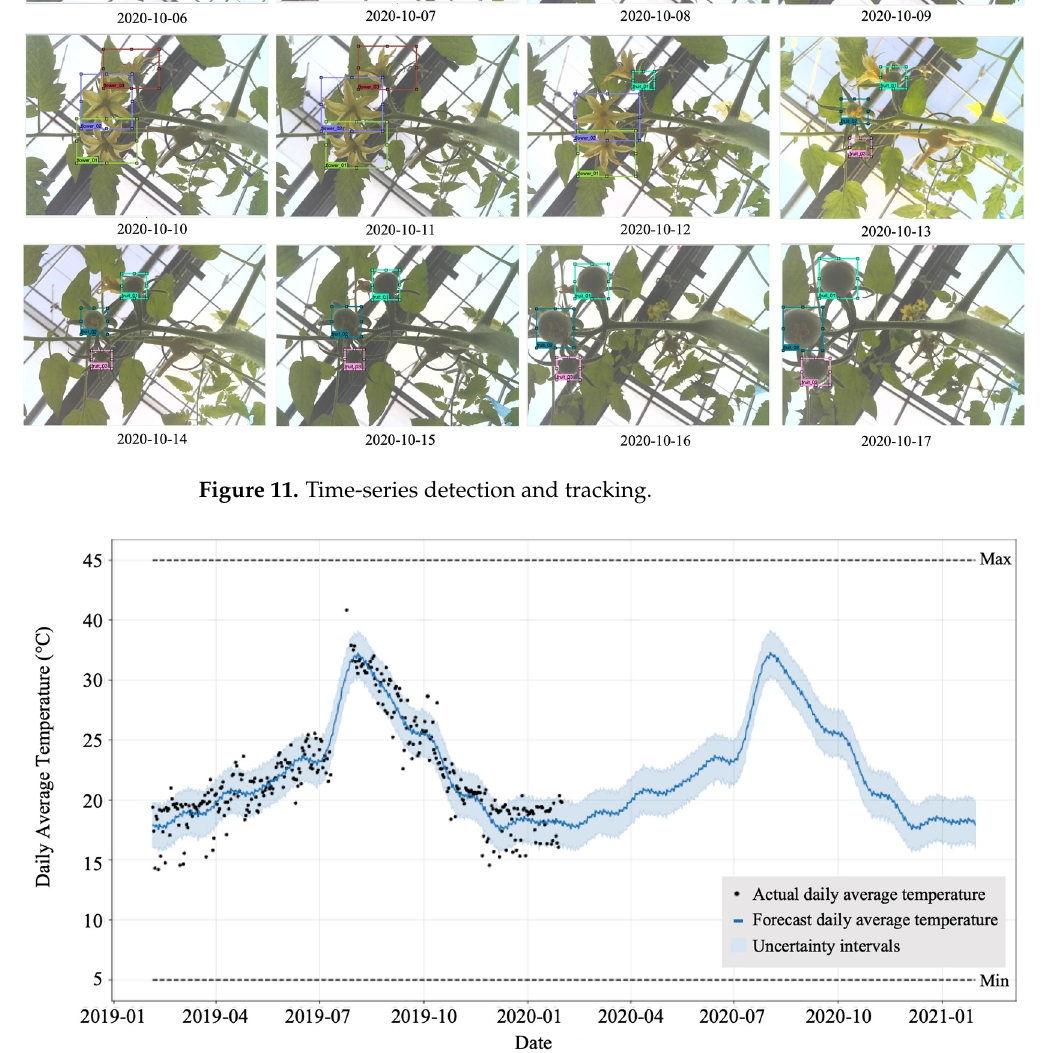
Figure 12. Daily average temperature prediction model.